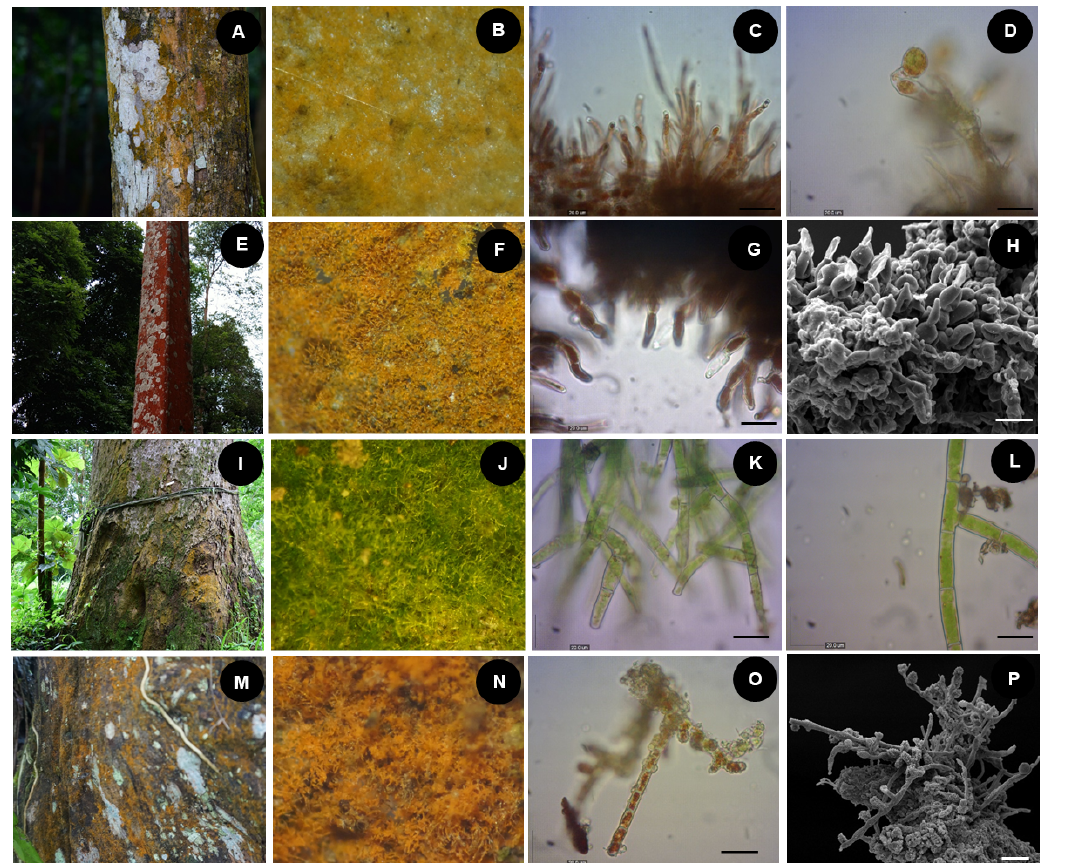
Figure 3 Subaerial green algae genus Trentepohlia at 13 sampling points in the rainy, winter, and summer seasons, including T. chapmanii ( A–D ), Trentepohlia sp. 1 ( E–H ), Trentepohlia sp. 2 ( I–L ), and T. sundarbanensis ( M–P ). Scale bars: 20 µ m.